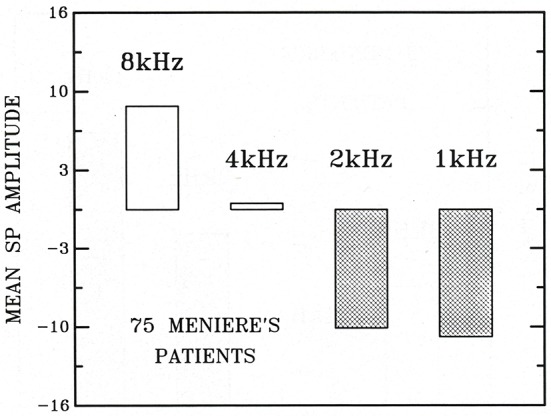
The mean tone burst SP amplitudes (in mV) in 75 Meniere's patients at 1, 2, 4, and 8 kHz, respectively (Dauman and Aran, 1991). Reproduced from Dauman and Aran (1991).